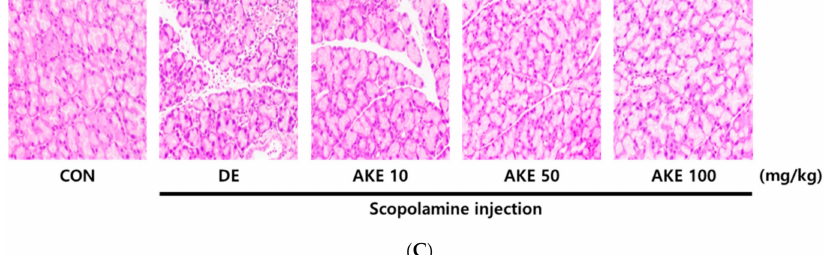
Figure 3. E ff ects of A. koraiensis ethanol extracts (AKE) on the inflammatory response and gap between tissues in the lacrimal gland. Dry eye (DE) was reportedly induced by scopolamine injection, and AKE was administered at 0 (control; CON which was not induced by scopolamine injection, DE), 10 (AKE 10), 50 (AKE 50), or 100 mg / kg (AKE 100). ( A ) Expression of inflammatory cytokines was accessed using RT-qPCR for each target gene (IL-1 β , TNF- α , IFN- γ , and Transforming growth factor beta (TGF- β )). β -Actin was used as an internal control. ( B ) Inflammatory proteins were analyzed by western blot (WB). (Upper panels) Representative figures of WB for phosphorylated inhibitor of nuclear factor kappa B (IkB) and total IkB, phosphorylated nuclear factor kappa B (NF- κ B), and total NF-kB were targeted. Quantitative analysis revealed the ratio of phosphorylated protein / total protein. (Lower panels) The representative figures and their analyses of WB for cyclooxygenase (COX)-1 and COX-2. GAPDH was used for the loading control. ( C ) Representative H & E-stained histological sections of lacrimal glands. The white area in the image shows the gaps between tissues in the lacrimal gland. Each bar represents the mean ± SD of n = 7 mice per group. # p < 0.05, ### p < 0.001 versus CON; * p < 0.05, *** p < 0.001 versus DE. Data were analyzed statistically using one-way ANOVA followed by Tukey’s post hoc